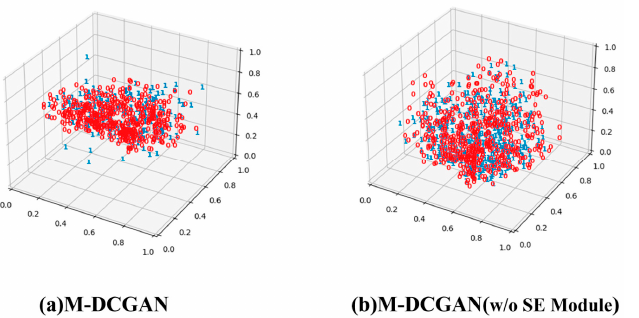
Figure 9. t-SNE visualization of the morphological distribution of generated images and real mask images.